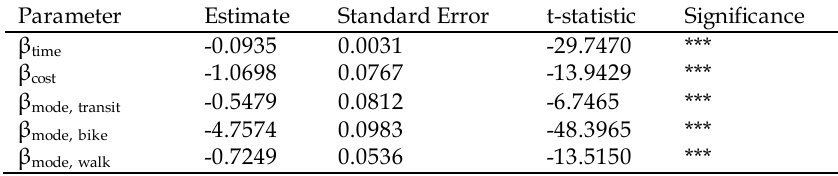
Table 1. Mode Choice Model Estimation